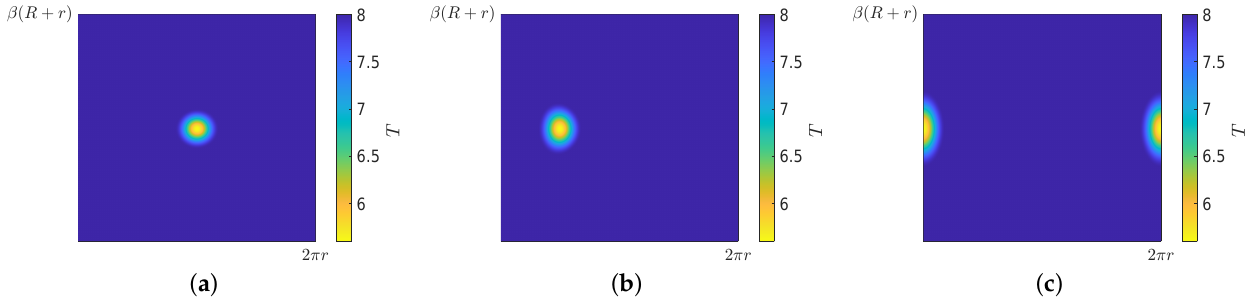
Figure 5. Thickness T (mm) in the 2D acoustic domain with a Hann-shaped defect at three different locations: ( a ) extrados, ( b ) top, and ( c )